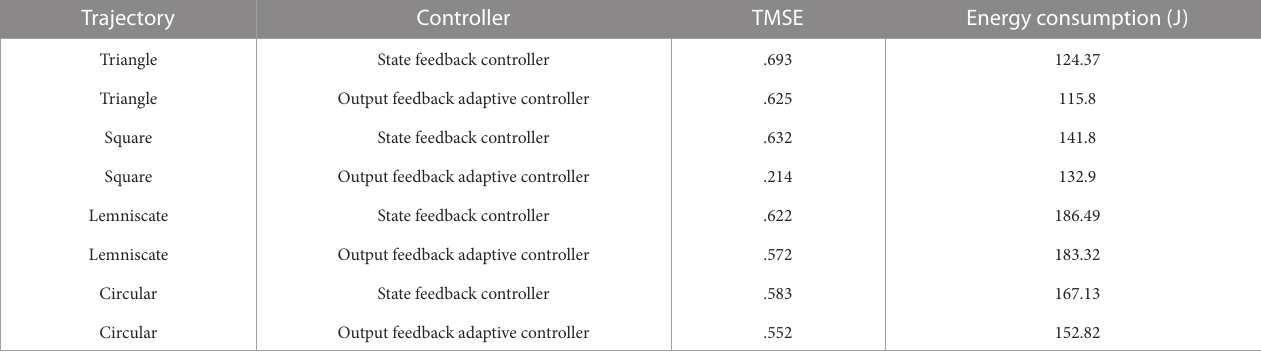
TABLE2 ComparisonoftheimplementedOFACagainstanSFCforvarioustrajectorytrackingonanSSARP-basedSAR.